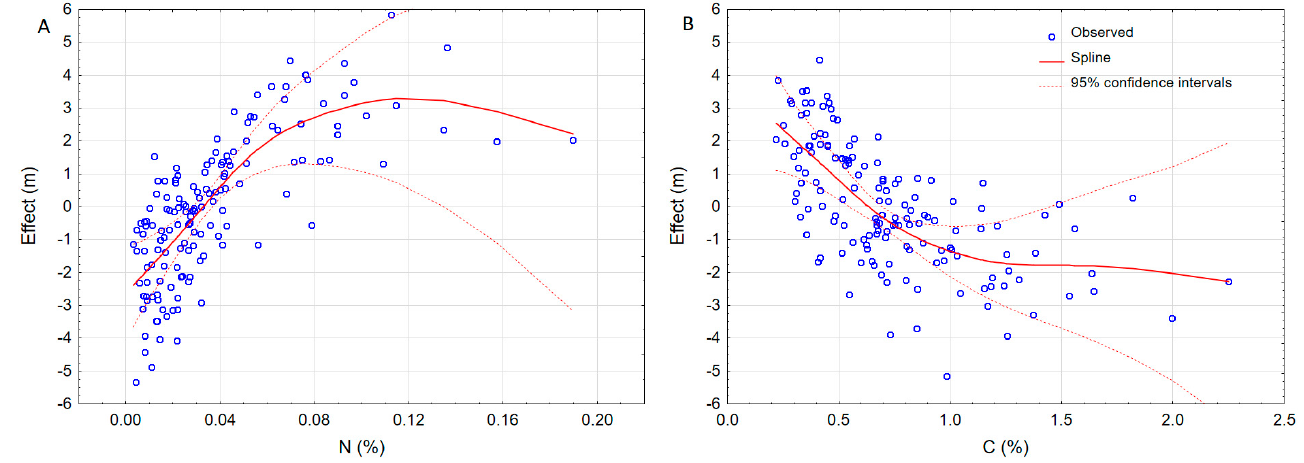
Figure 2. Partial effects of nitrogen content ( A ) and carbon content ( B ) in soil on the site index (SI) for oak. The effect of nitrogen and carbon content change is displayed with all other factors held constant.